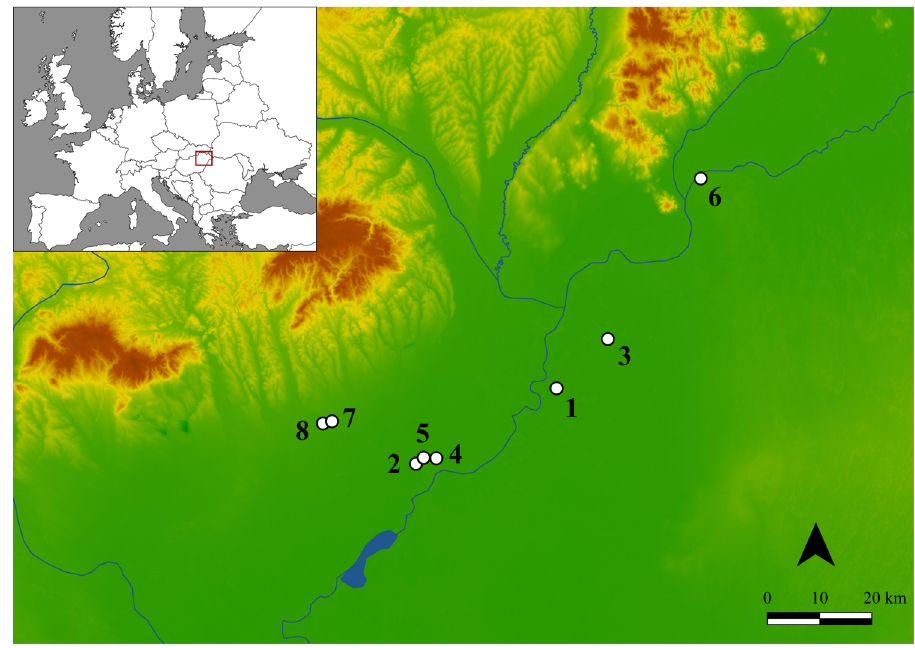
Figure 3: Location of the analysed sites: ( 1 ) Tiszapolgár - Basatanya; ( 2 ) Tiszavalk - Kenderföld; ( 3 ) Polgár - Nagy - Kasziba, ( 4